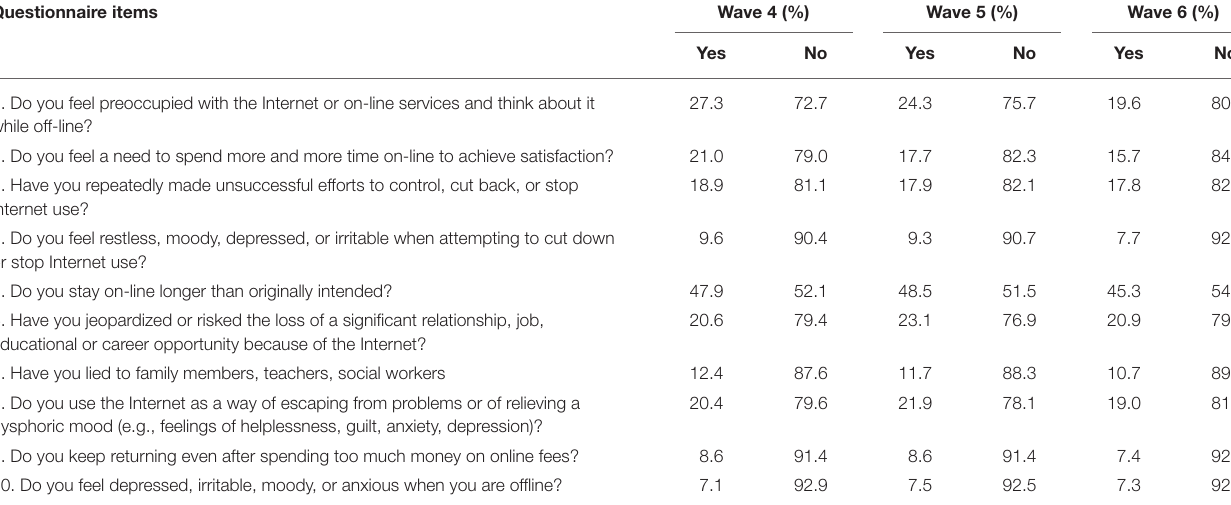
TABLE 2 | Participants’ answers on Internet Addiction questionnaire across the three waves ( N = 3,074). Questionnaire